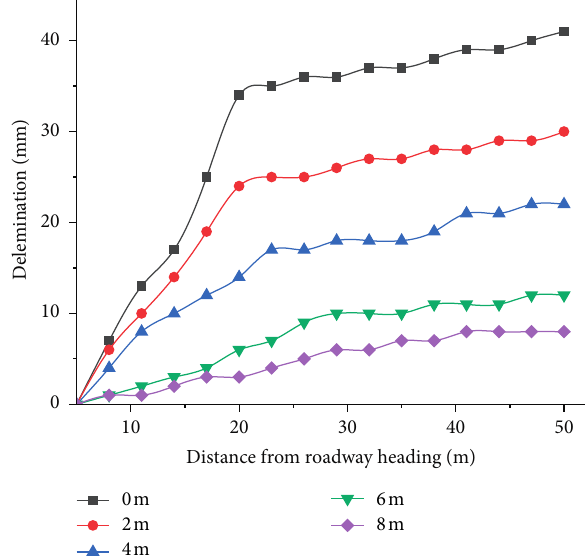
Figure 15: Displacement of surrounding rock at different depth in the No. 3